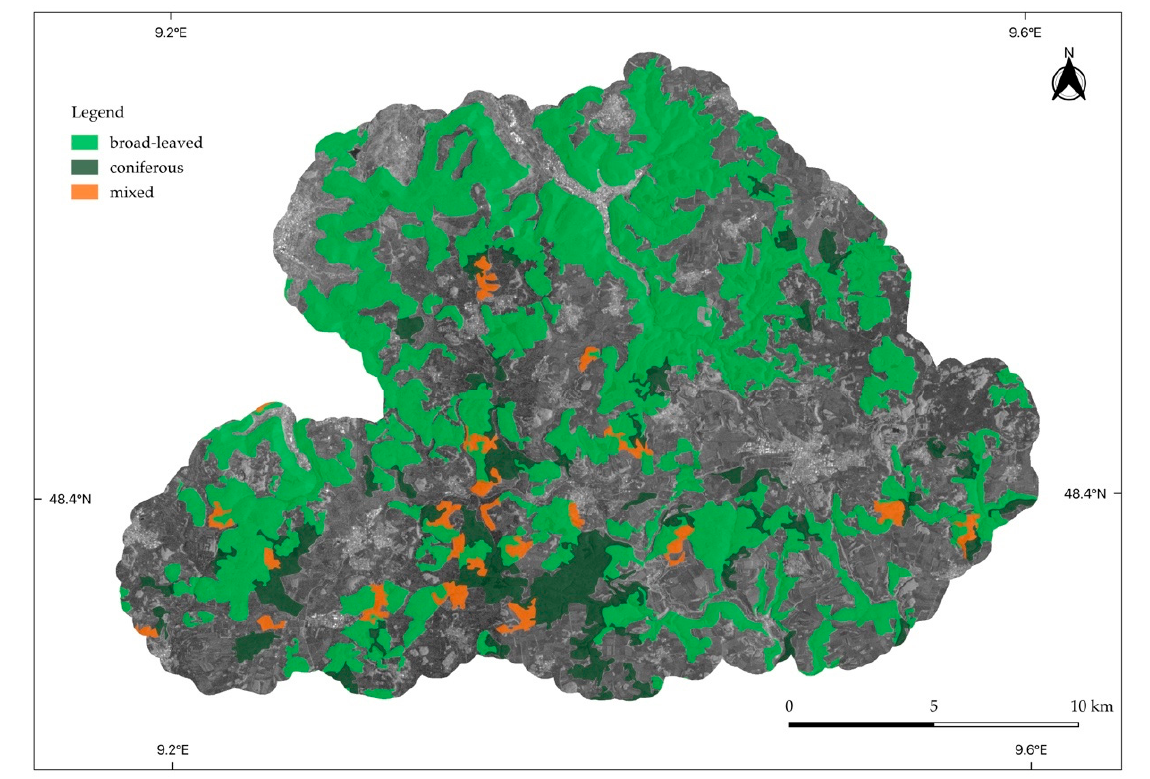
Figure 4. Location of the study site Swabian Alb. Forest type cover information was taken from the Corine Land Cover Dataset 2018 (© European Union, Copernicus Land Monitoring Service 2021, European Environment Agency).